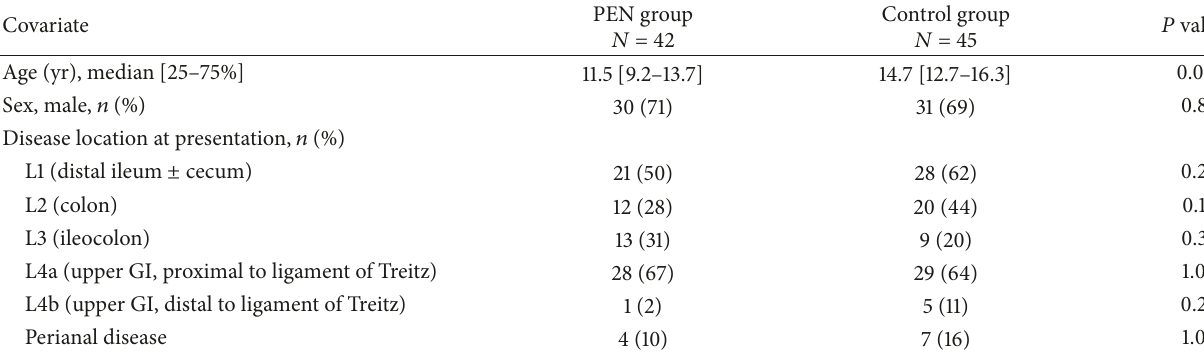
Table 1: Basic characteristics of the study population at the time of diagnosis.